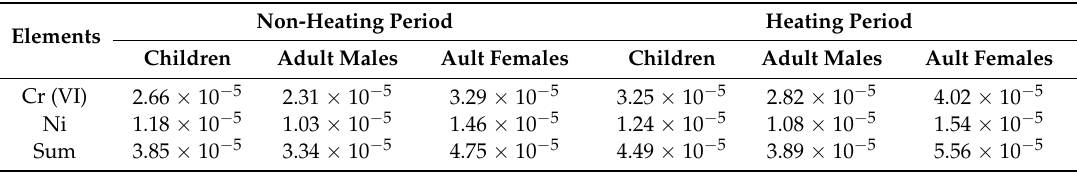
Table 12. The carcinogenic risks of heavy metals via ingestion.